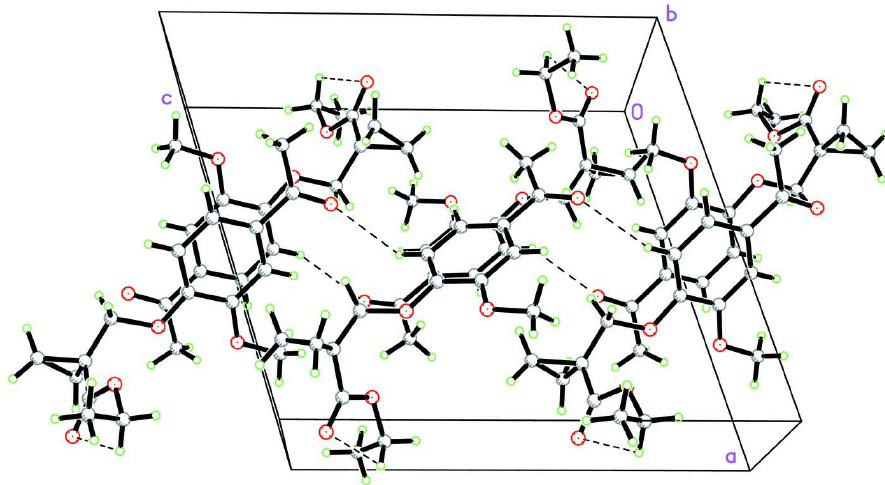
Figure 2 A packing diagram for (I). C—H···O hydrogen bonds are shown as dashed lines. Ethyl